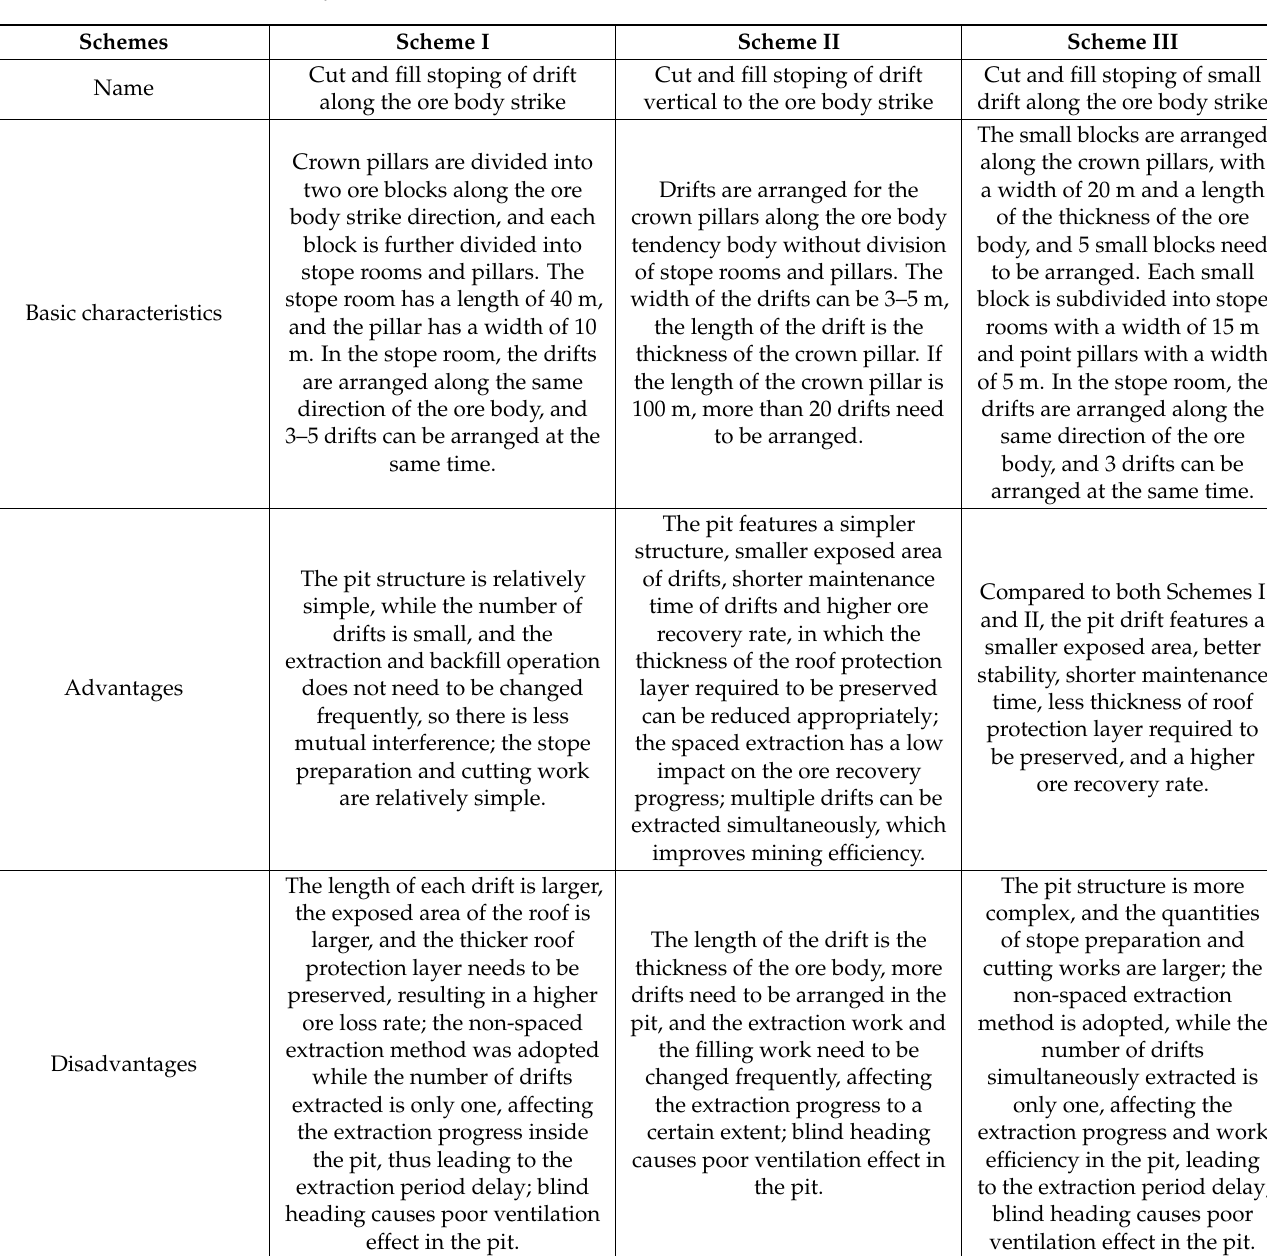
Table 1. Basic Characteristics and Advantages and Disadvantages of Three Crown Pillar Recov- ery